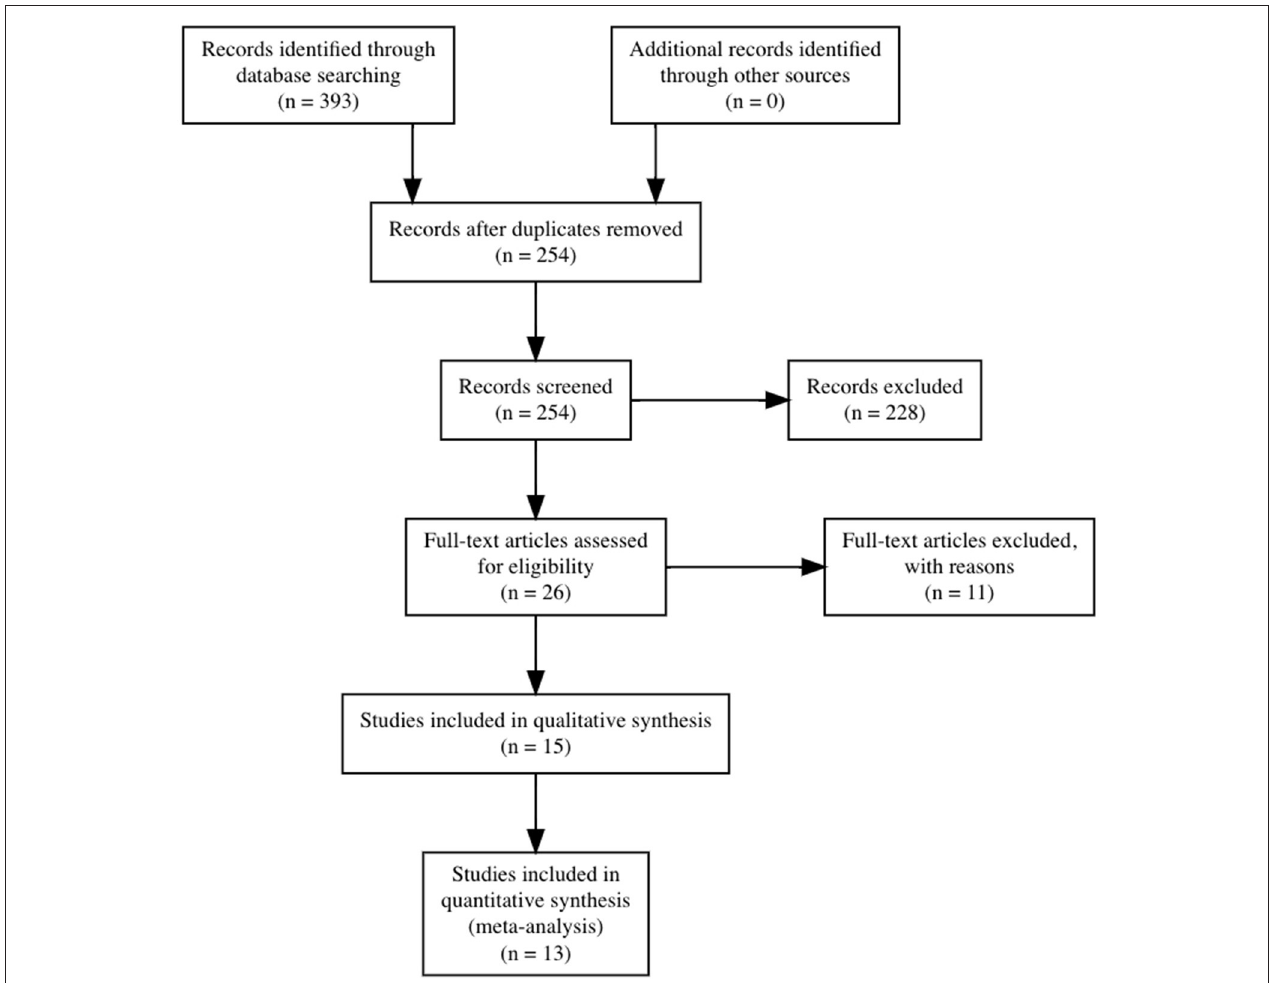
FIGURE 1 | Preferred Reporting Items for Systematic Reviews and Meta-analysis (PRISMA) flow